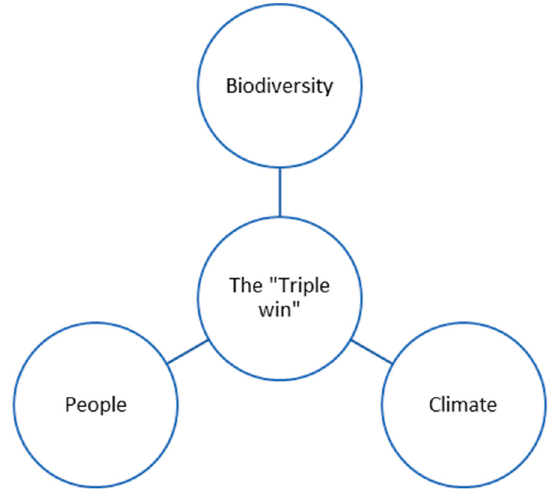
Figure 4. The “triple win” UK government framework for projects to deliver on enhancing biodiversity, addressing climate change and reducing poverty [46].